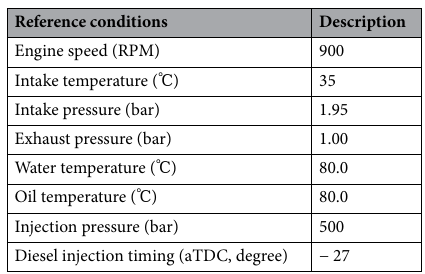
Table 2. The reference metal engine experimental conditions.